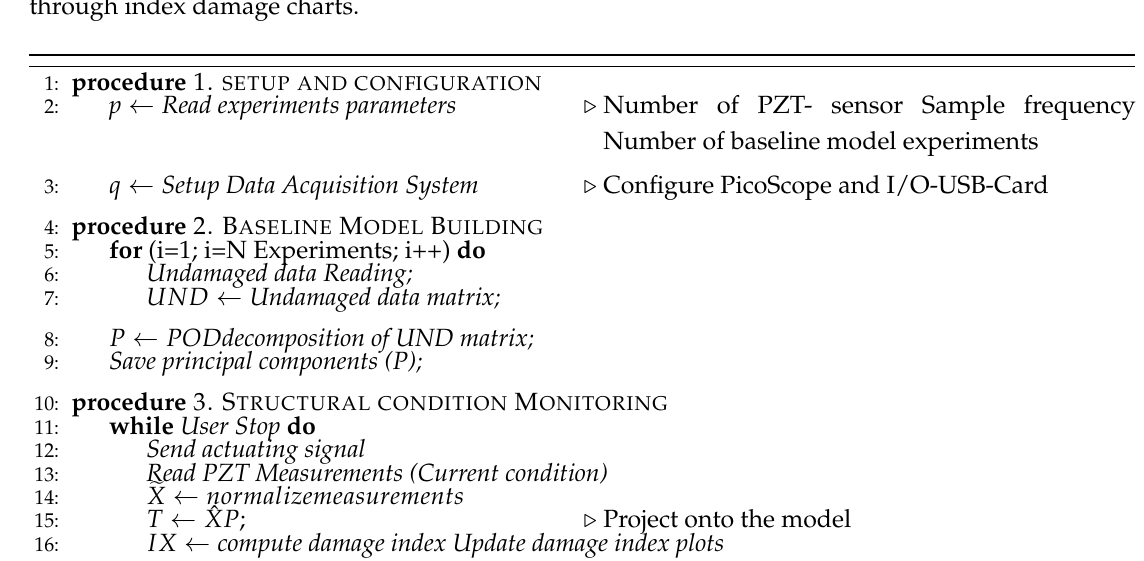
Figure 6. PCA-Based Piezodiagnostic Damage-Detection